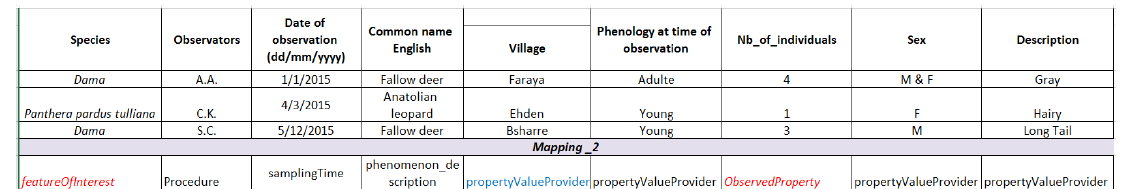
Figure 5. Running example: mapping on the geographic area.